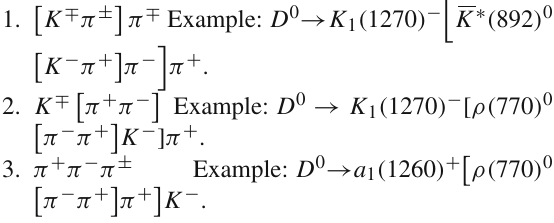
state P 4 and an unstable state X . The unstable state then decays to three pseudoscalars P 1 , 2 , 3 via another interme- diate unstable state ( Y ). There are three distinct possi- bilities for cascade decays. The resonance X can either have isospin I = 1 / 2, and will therefore decay into the K ∓ π ± π ∓ final state, or have isospin I = 1 and therefore will decay into the π + π − π ± final state. In the K ∓ π ± π ∓ case, the next state in the cascade Y can either be in K ∓ π ± or π + π − , referred to as cases (1) and (2), respec- tively. In the π + π − π ± case, there is only the π + π − state, referred to as case